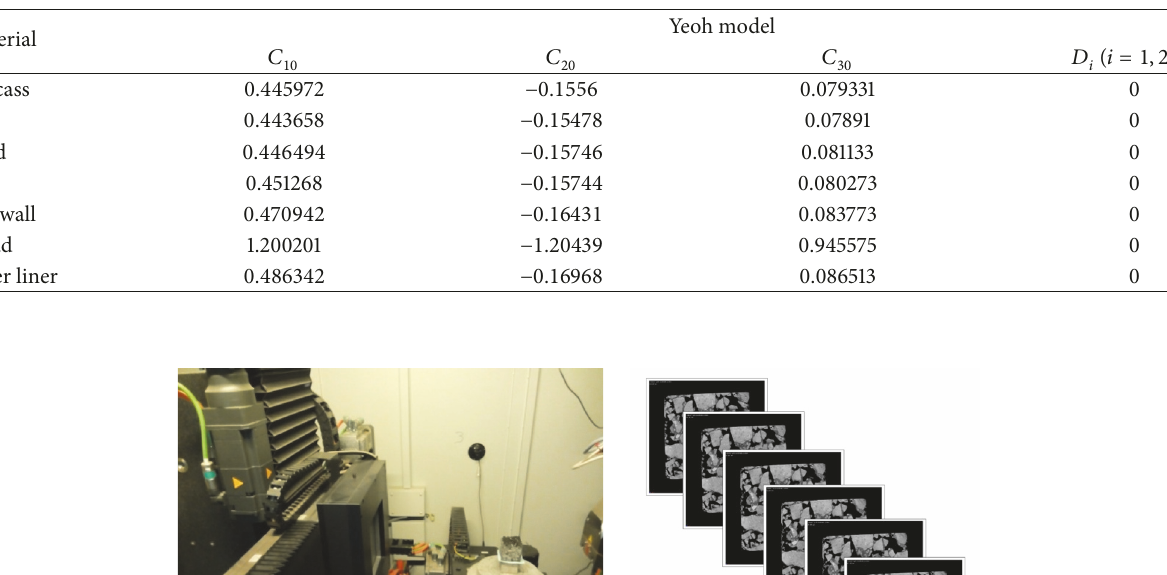
Table 2: Parameters of Yeoh model.